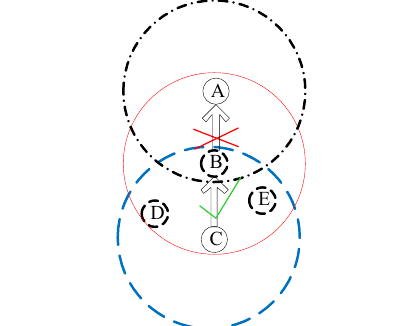
Figure 4. The presence of a void-hole. Node X advances data to Y. However, Y cannot advance data towards the water surface as it has no neighbor in that direction. It shows that a void-hole exists beyond Y.